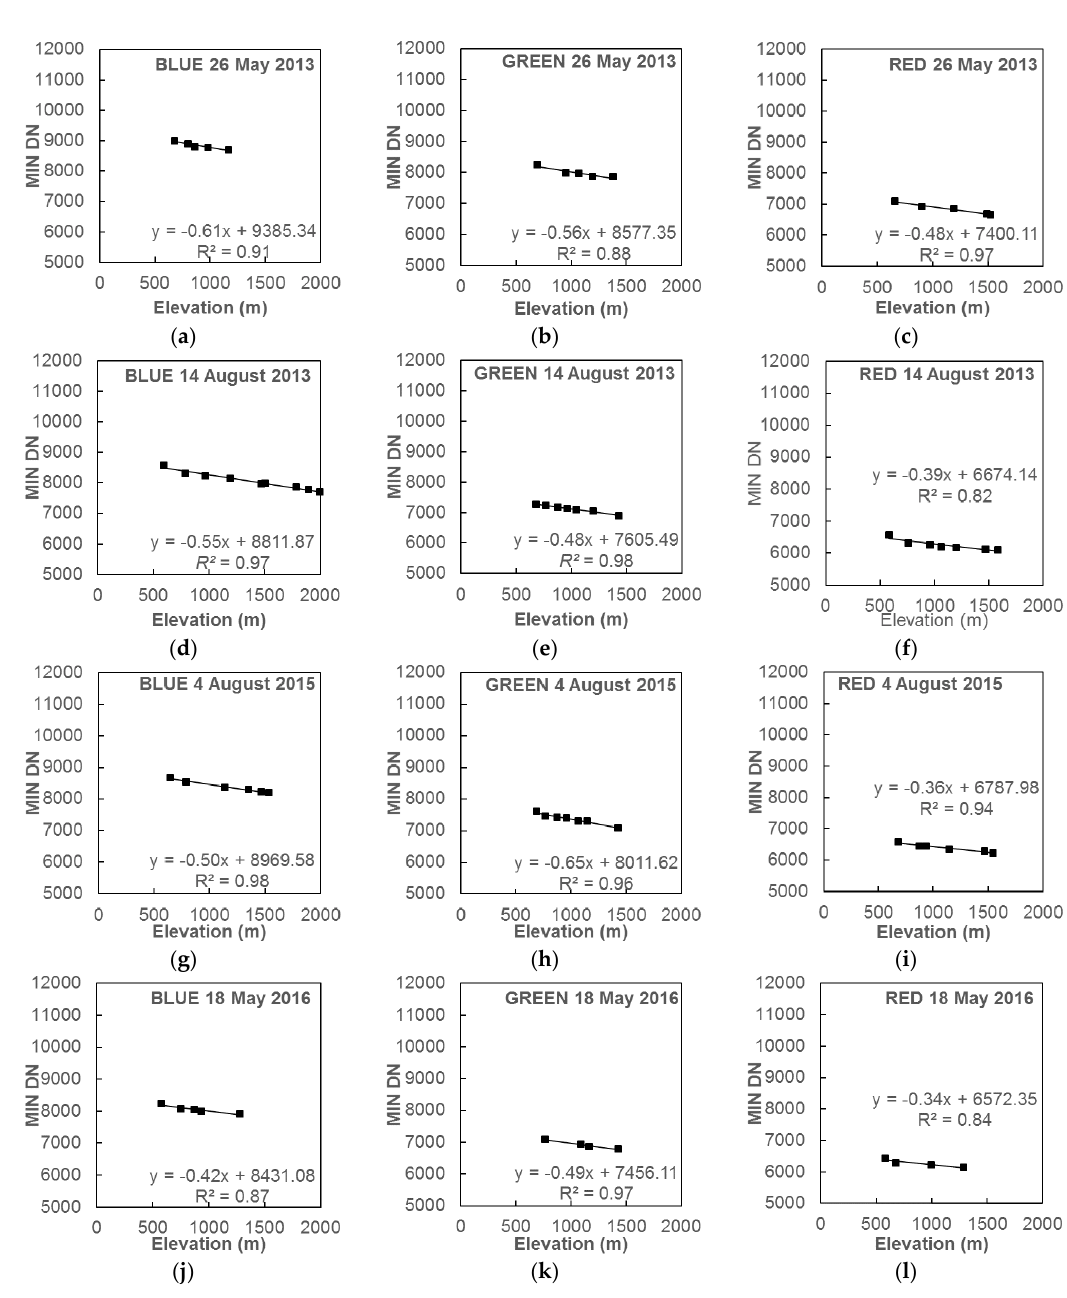
Figure A1. Linear regressions of MIN DN on elevation for bands 2–4 of Landsat OLI sub-images dated